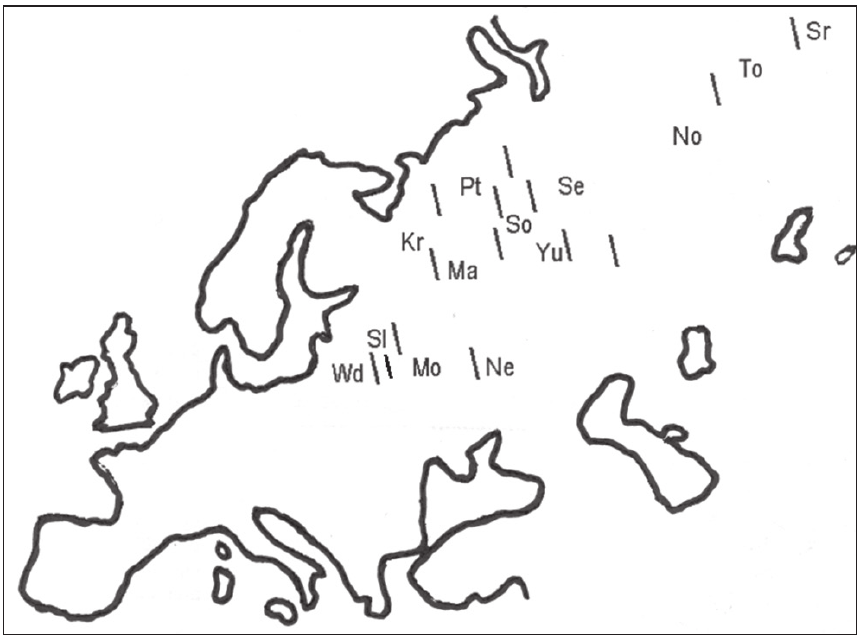
Figure 1. Schematic view of geographic distribution (slash) of hybrid zones between chromosome races of Sorex araneus in Russia. Standard abbreviations are used for the racial names (see